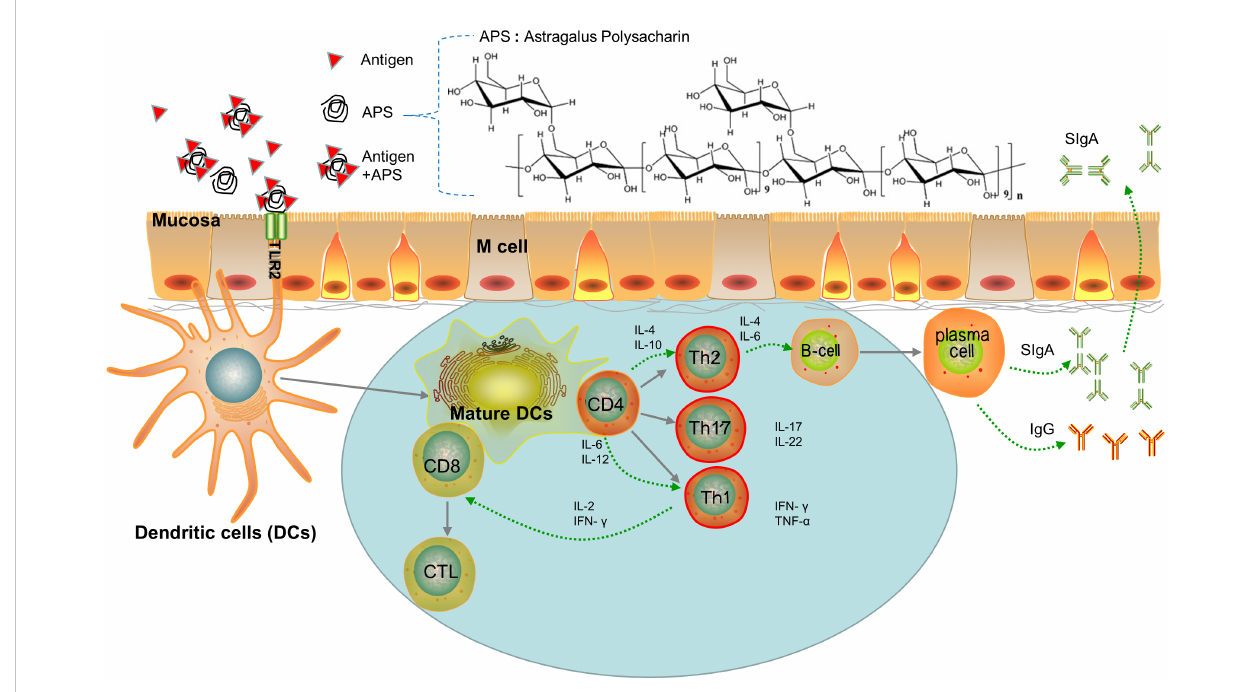
FIGURE 1 Paradigm of APS as Mucosal Immune Adjuvant. (i) Adjuvants are recognized by the TLR2 ligand of DCs and promote naive T differentiation. (ii) Th cells promote B cell differentiation into plasmacells which secrete IgA or IgG. (iii) DCs presents antigens that promote the transformation of CD8 cells into cytotoxic T lymphocytes